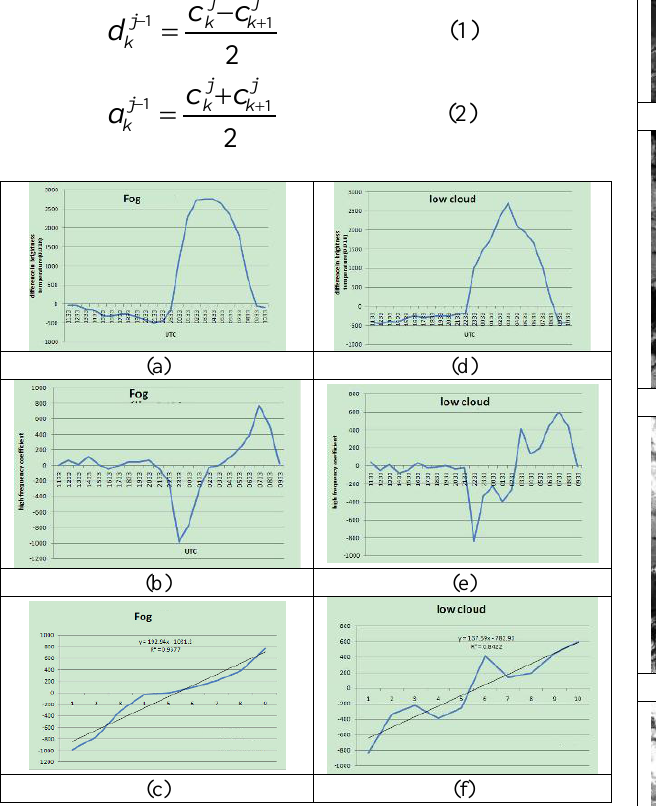
Figure 1. discriminate fog and low cloud by using non- orthogonal Haar wavelets: (a) original signal of fog, (b)fog‟s high frenquency part after Haar wavelet transform, (c) original signal of low cloud, (d)low cloud‟s high frenquency part after Haar wavelet transform,(e) the line fitting for fog signal, (f)